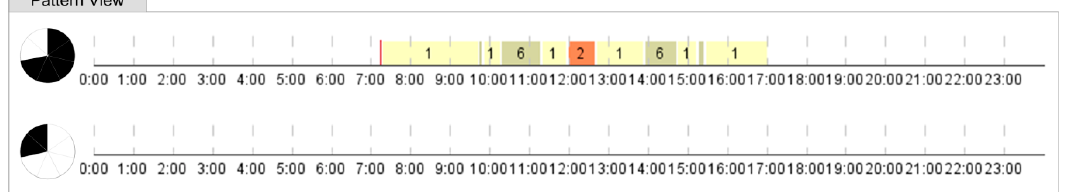
Figure 11. The route patterns of the cluster 2 of the Engineers department.